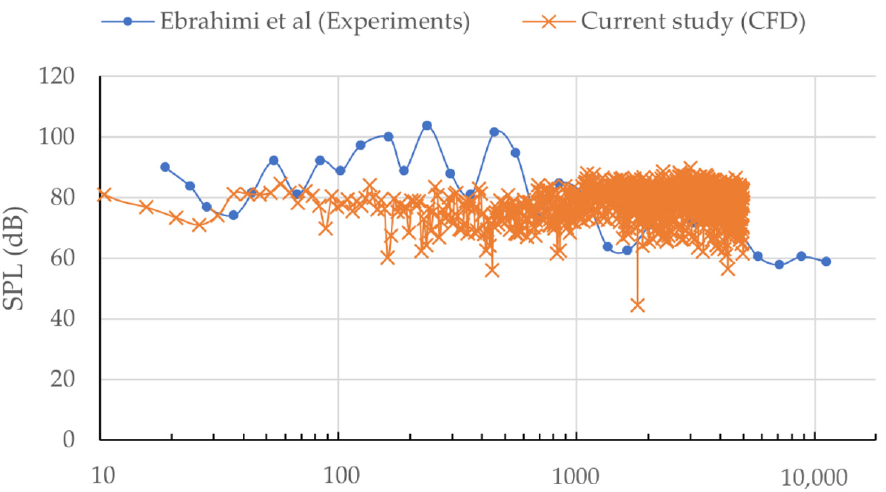
Figure 4. Propeller noise validation of the current model compared to literature finding, J = 0.7. Reproduced with permission from Ebrahim et al. [31].